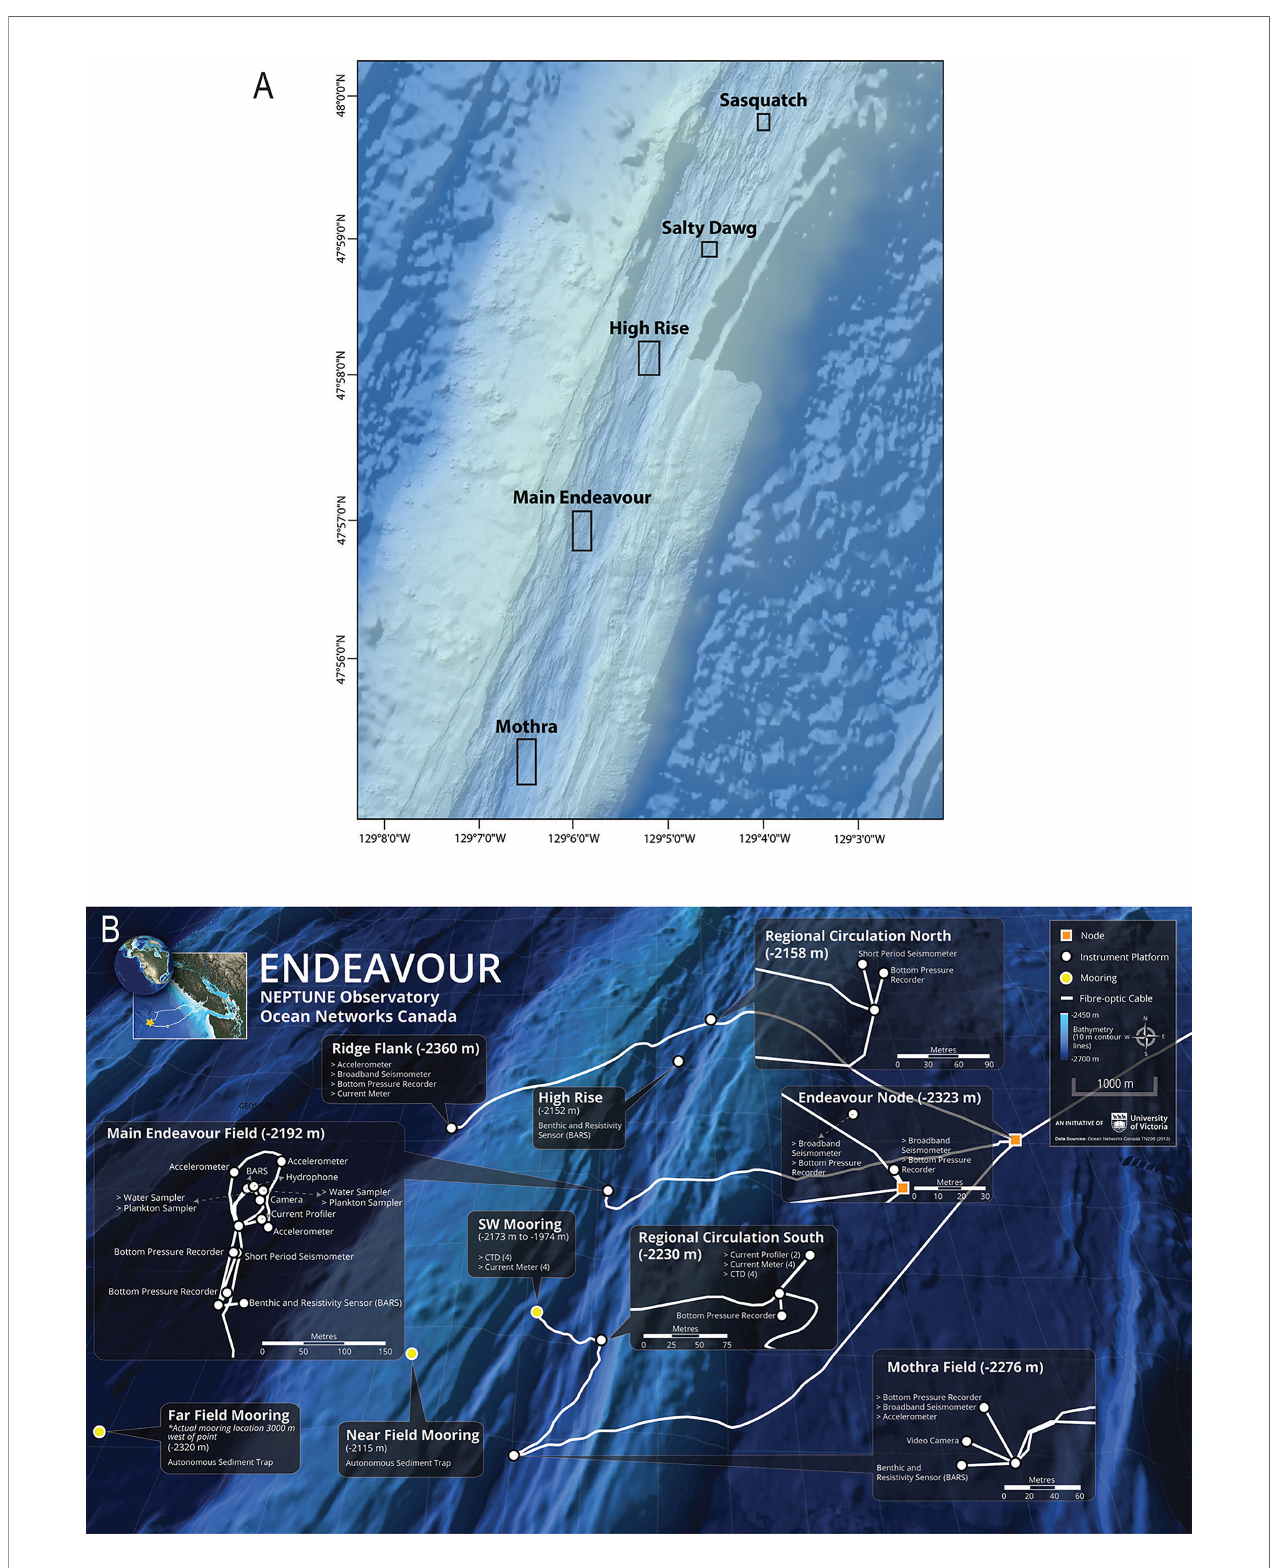
FIGURE 3 | The Ocean Networks Canada on the Endeavour segment of the Juan de Fuca Ridge. (A) Regional bathymetry showing the main hydrothermal vent fi elds. (B) Details of the instruments location at the Endeavour